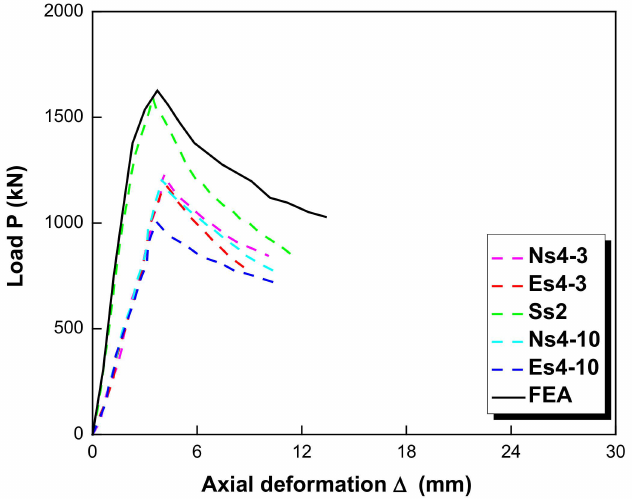
Figure 5. Axial load (P)—axial deformation ( ∆ ) of the FEA and the experimental tests for the SCFST